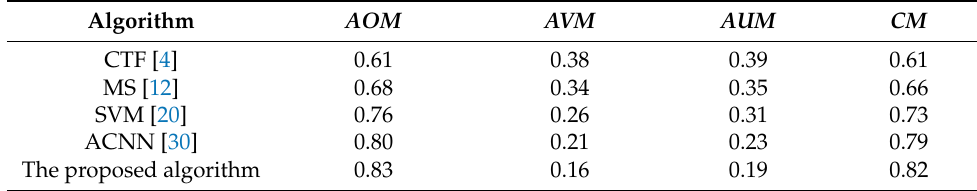
Table 4. Cloud detection results of database